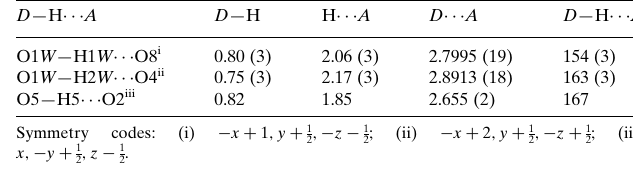
Hydrogen-bond geometry (A˚ , (cid:4)